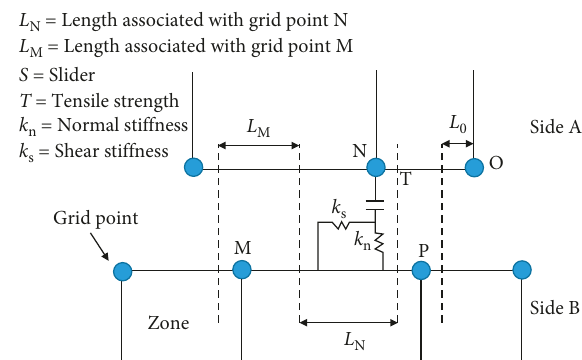
Figure 4: An interface condition between A and B sides.